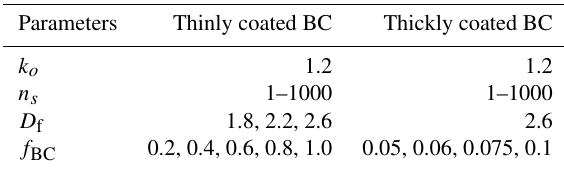
Table 1. Morphological parameters of BC aerosols, where f BC rep- resents the volume fraction of